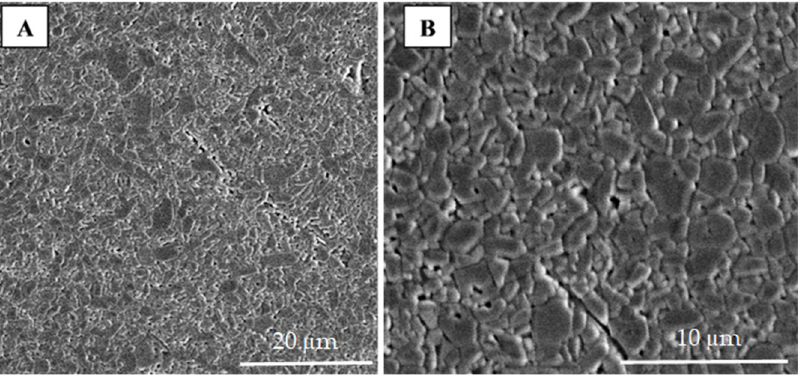
Figure 3. SEM image of the alumina ceramics sintered in a hybrid microwave kiln at different mag- nifications: ( A ) 2500×, ( B ) 6000×. magnifications: ( A ) 2500 × , ( B ) 6000 × .